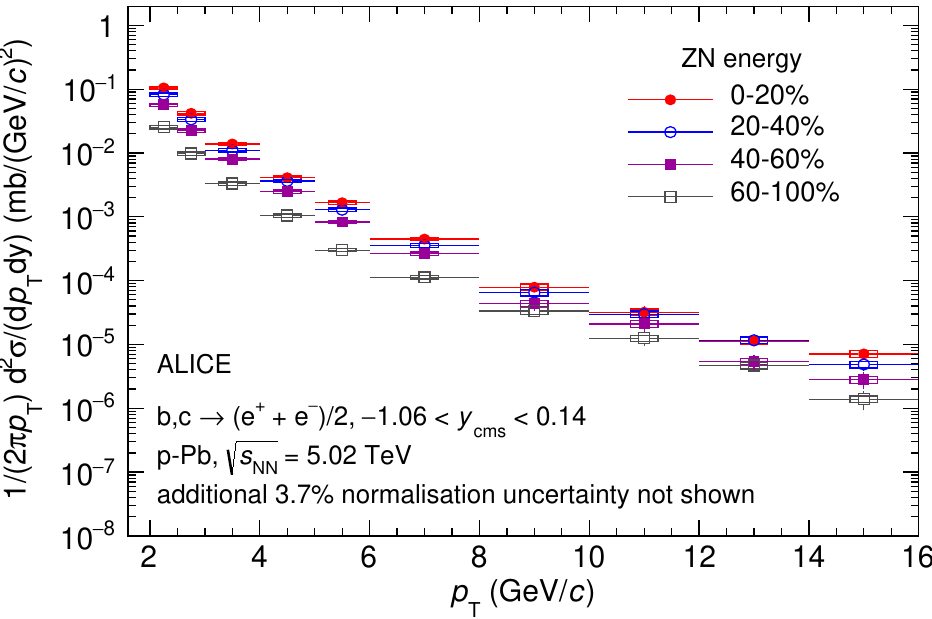
Figure 5 . The p T -di(cid:11)erential invariant cross section of electrons from heavy-(cid:13)avour hadron decays in several charged-particle multiplicity classes in p-Pb collisions at tical uncertainty of each spectrum is indicated by error bars and the systematic uncertainties are indicated by